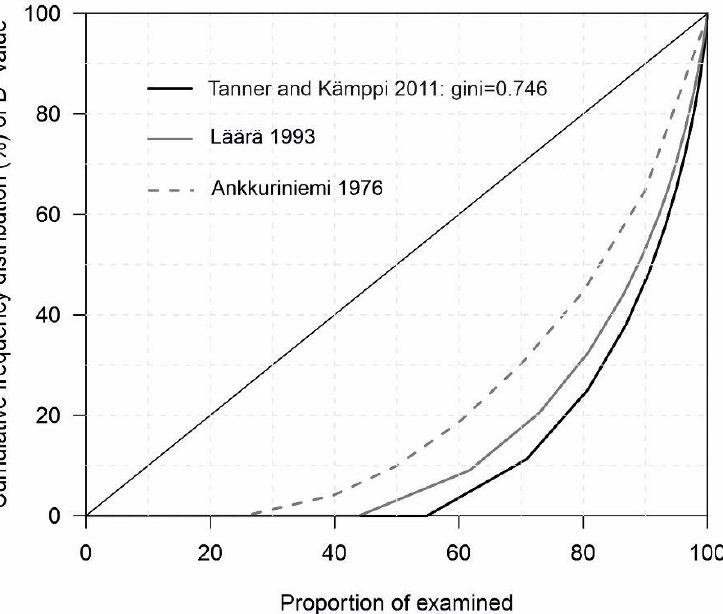
Figure 2. Summary of previous cross-sectional studies [5–8] polarizations (Lorentz curve) of Finnish conscripts. The curves of Ankkuriniemi and Läärä were manually adjusted from their dissertations .